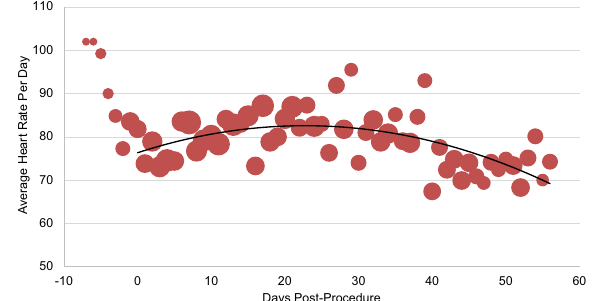
Fig. 5 Average heart rate per day for patients who underwent atrial fi brillation ablation ( n = 30). Bubble size corresponds to number of patients for whom data were synced. Procedure occurred on day 0. Negative days indicate pre-procedure data, when available. Data obtained via AliveCor Kardia Mobile.